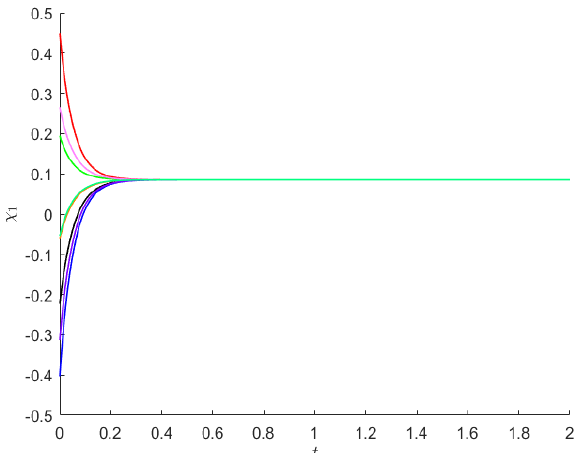
Figure 1. For Example 1, from 8 initial values (each shown using a separate color), are depicted the trajectories of state χ 1 .